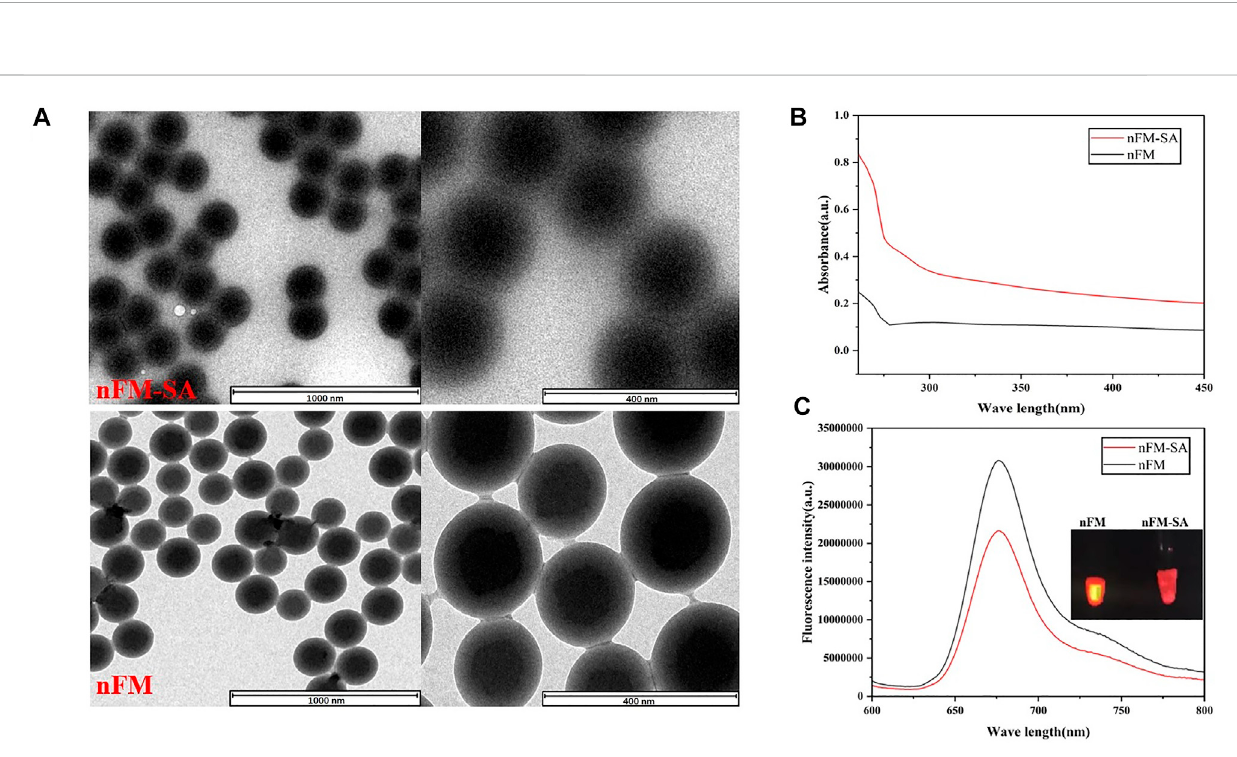
Frontiers in Bioengineering and